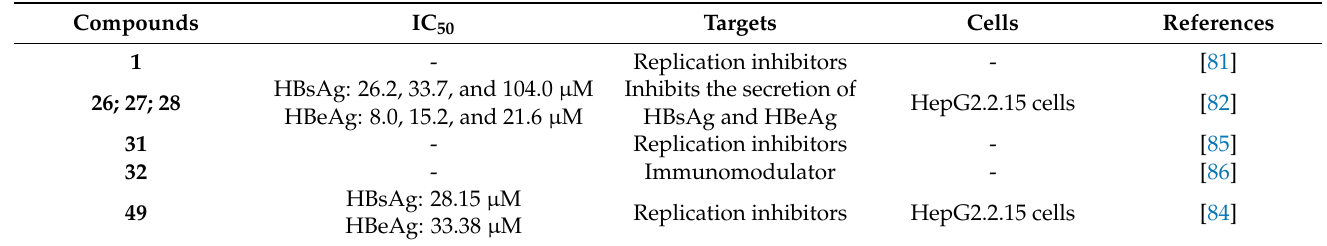
Table 5. Summary of anti-HBV triterpenoids and their targets and activities.